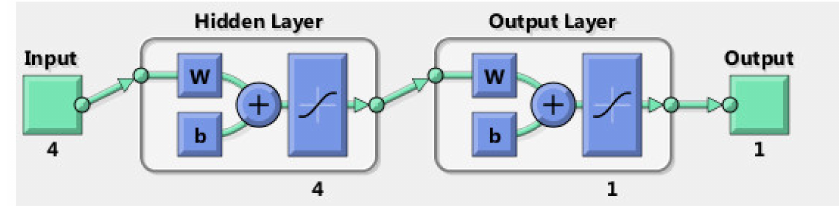
Figure 6. Architecture of Artificial Neural Network